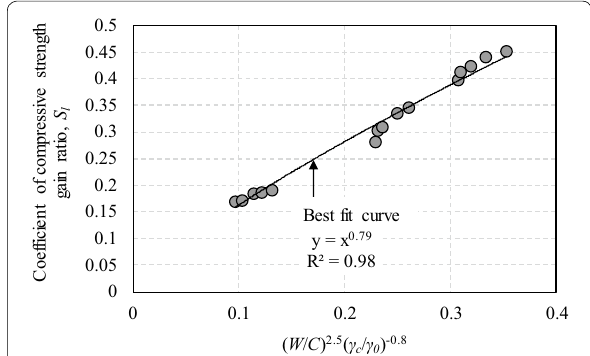
Fig. 7 Modeling of S l in Eq. (2) to estimate the compressive strength gain ratio of the LWAC‑BS.